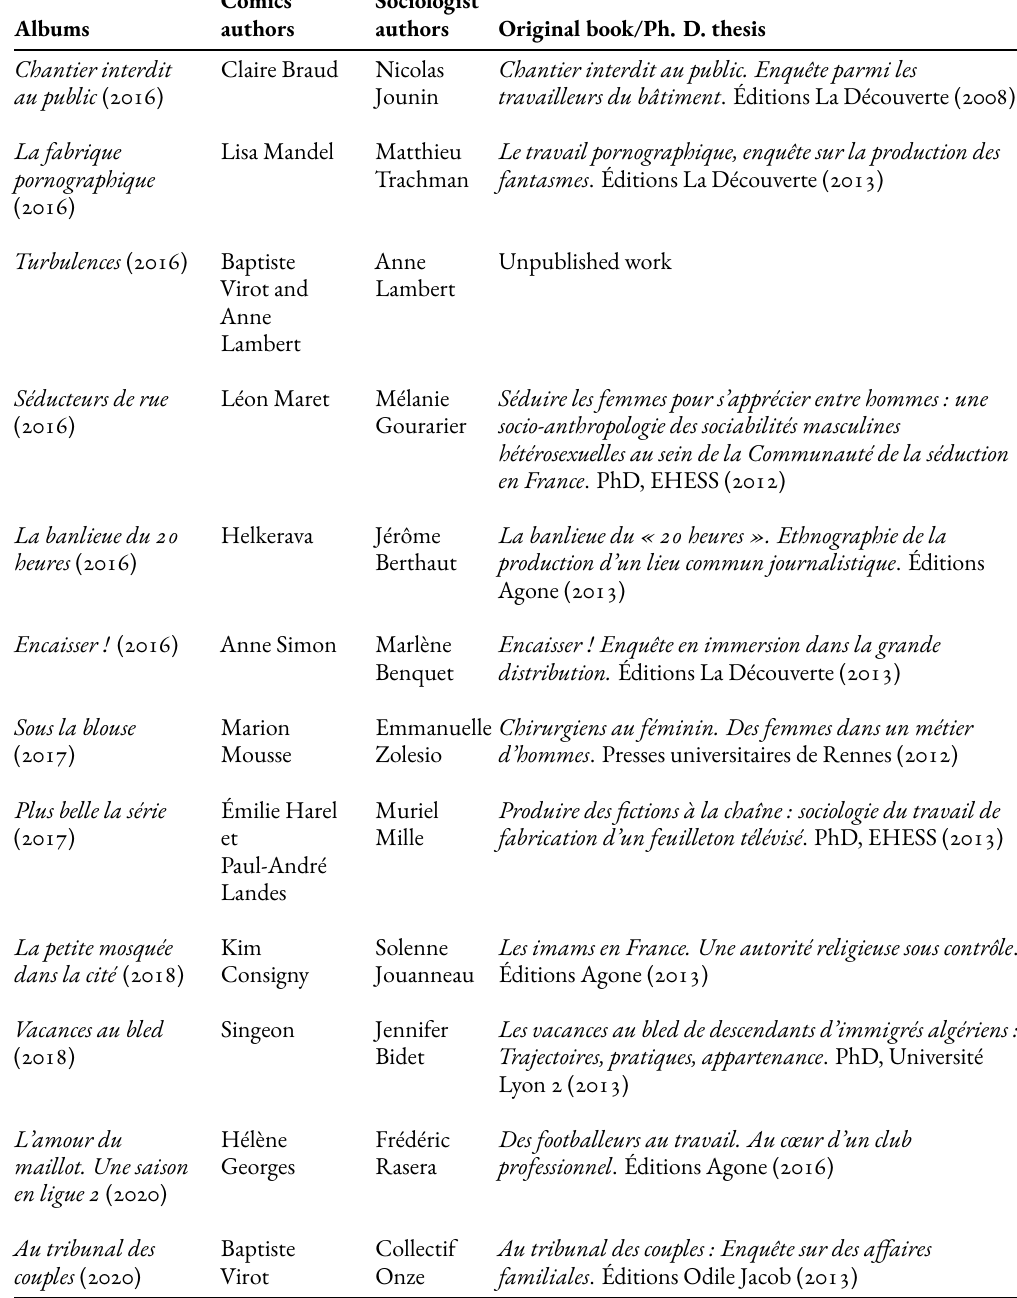
Table 1: List of Published